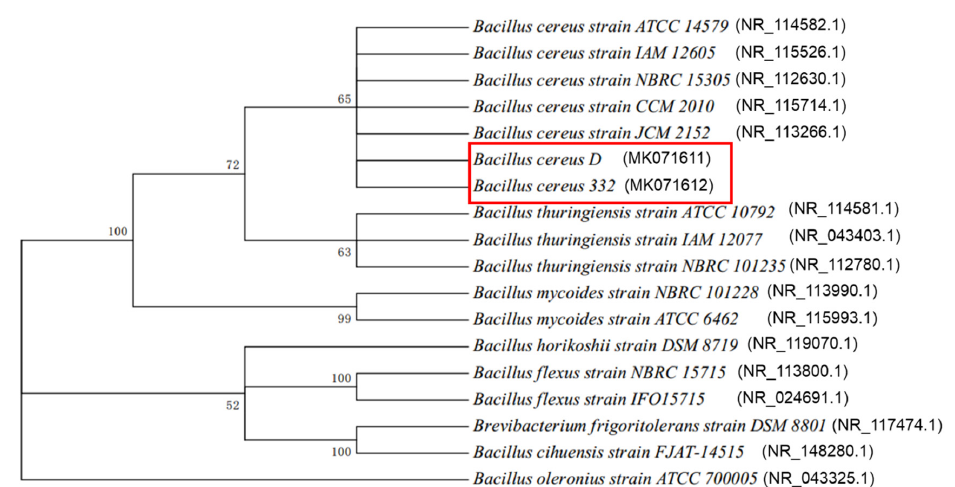
Figure 2. The phylogenetic tree generated from the 16S rDNA gene sequences of the two isolated strains, B. cereus D and B. cereus 332. Red block highlights the strains isolated in this study.